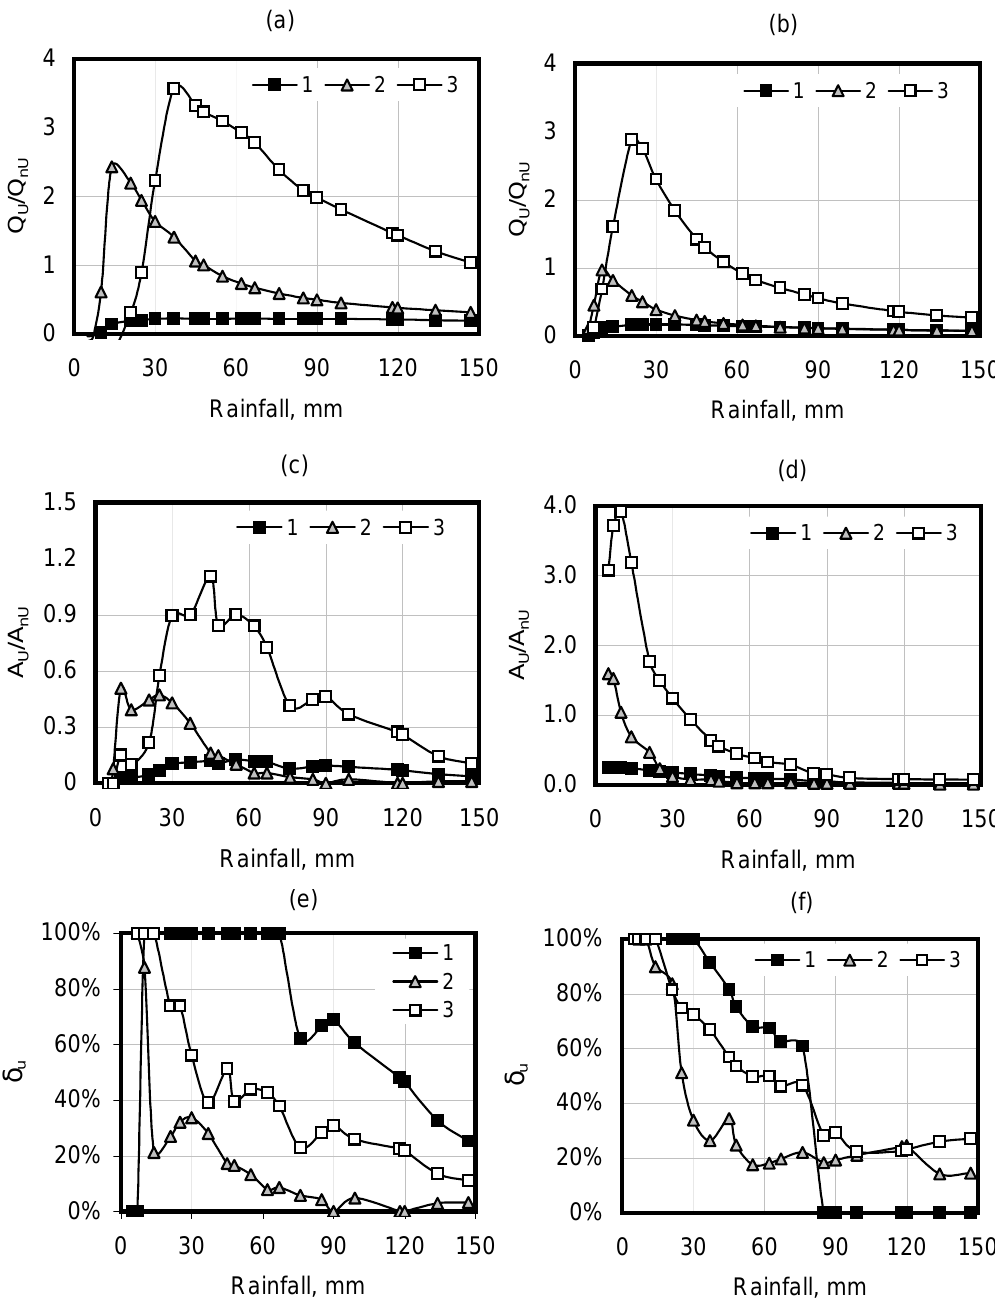
Fig. 12. Effect of urbanisation on the catchment runoff Q (a, b) , the catchment contributing area Acc (c, d) and the effect of the increase in catchment contributing area on volumetric runoff δ (e, f) during the storage recovery stage (a, c, e) and storage deficiency stage (b, d, f) for the entire runoff (1), sub-catchment with clay soil (2) and sub-catchment with sandy soil